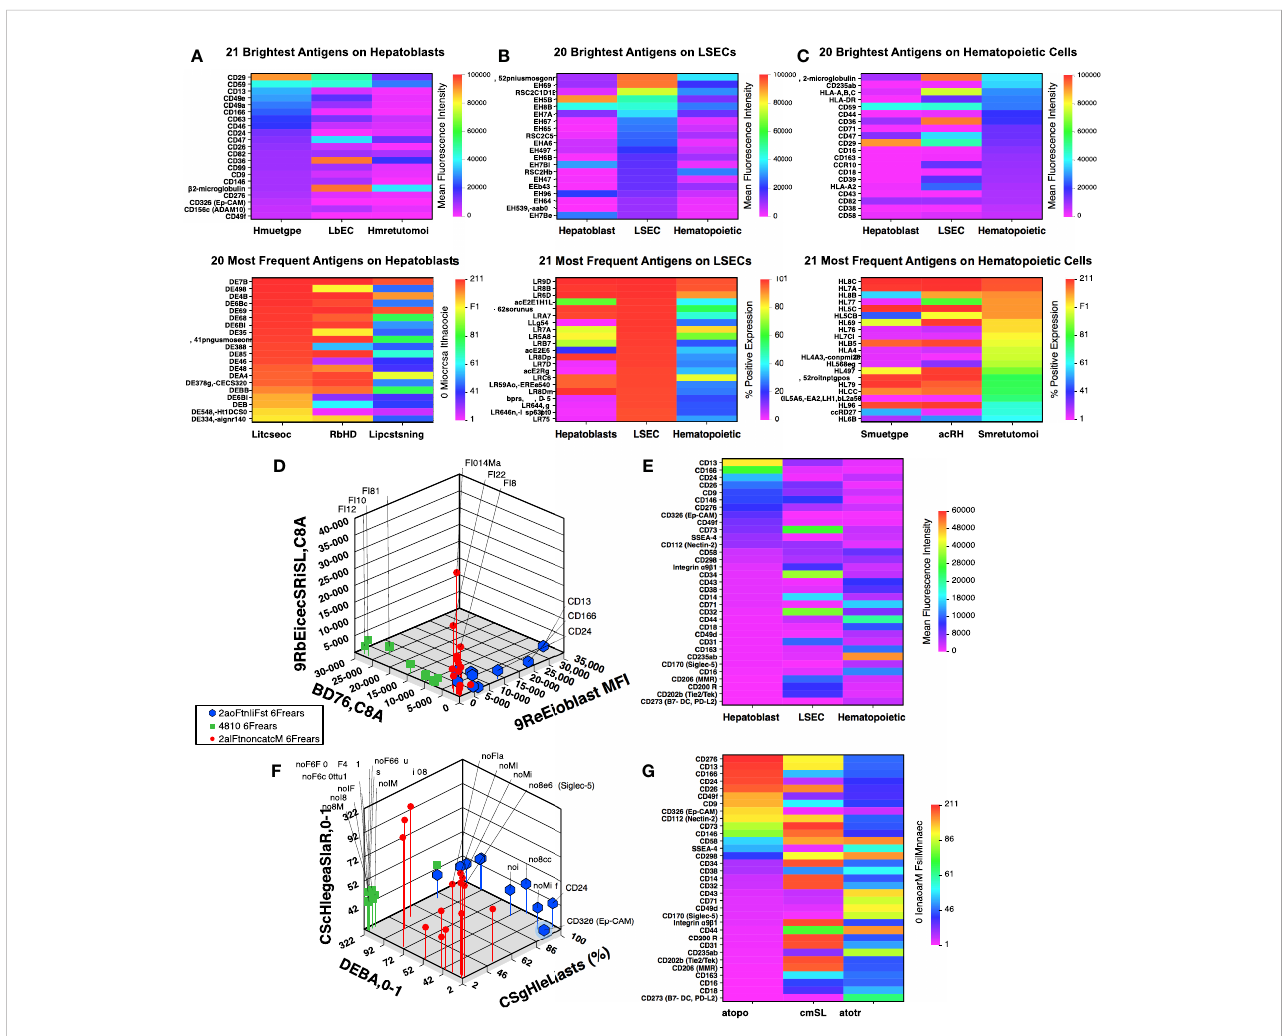
FIGURE 1 Flow cytometric array analysis of human fetal liver. Frequency and intensity of antigen expression on hepatoblasts (A) , LSECs (B) , and hematopoietic (C) cell populations from midgestation liver. Further description of the gated cell populations can be found in (21). Comparison of mean fl uorescence intensity (D) and frequency of expression (F) of 33 selected antigens (see text) using 3-dimensional scatter plots. Corresponding heat maps for mean fl uorescence intensity (E) and frequency of expression (G) for the 33 antigens are shown sorted based on antigen expression by